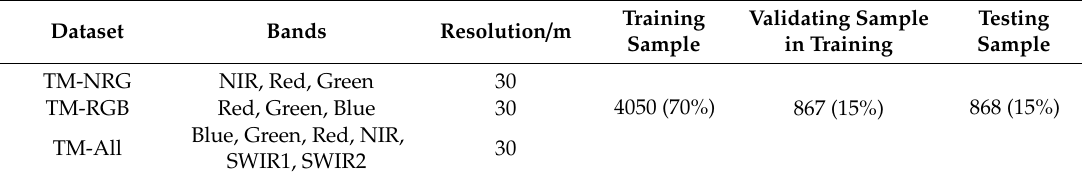
Table 3. Three di ff erent TM datasets used in this study.